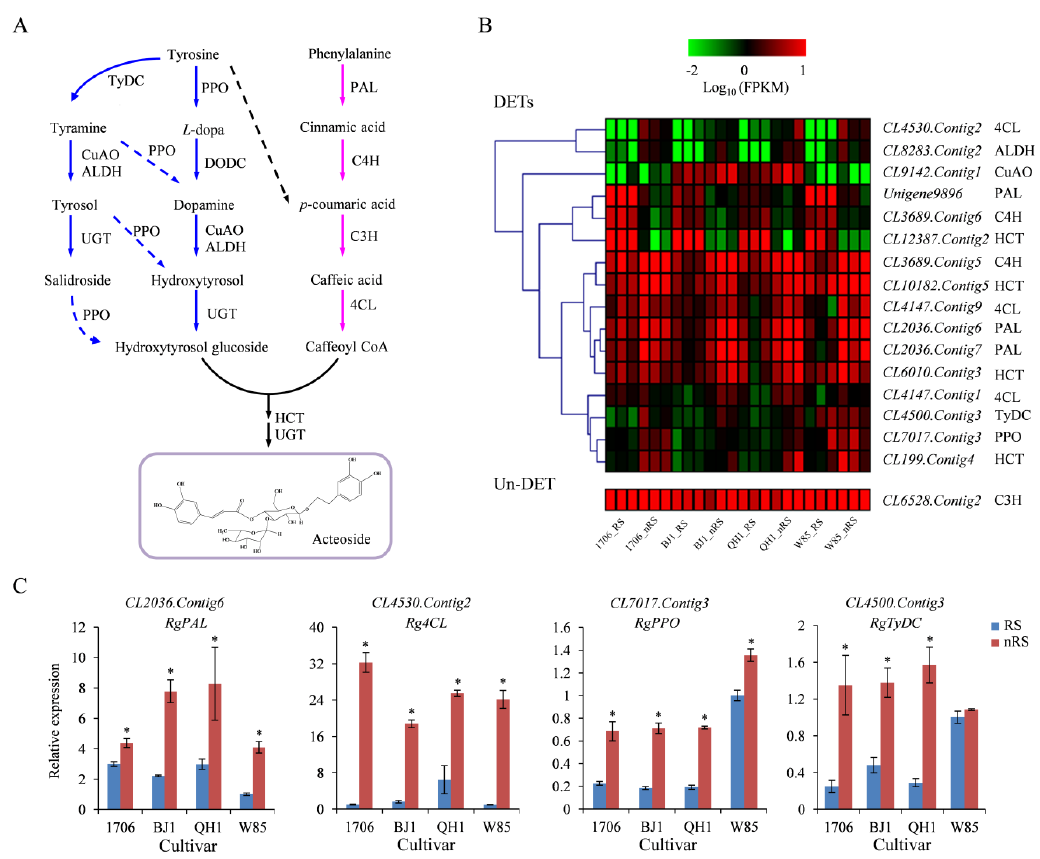
Figure 7. Expression patterns of acteoside biosynthetic unigenes between radial striations and non-radial striations of R. glutinosa. ( A ) Biosynthetic pathway of acteoside. The blue arrows indicate the tyrosine-derived pathway, and the purple arrows indicate the phenylalanine-derived pathway. The solid arrows denote known steps and the dashed arrows denote hypothetical steps. ( B ) Expression levels of the identified unigenes were annotated as enzyme coding genes from acteoside biosynthesis pathways. ( C ) Expression levels of unigenes involved in the biosynthesis of acteoside. Vertical bars